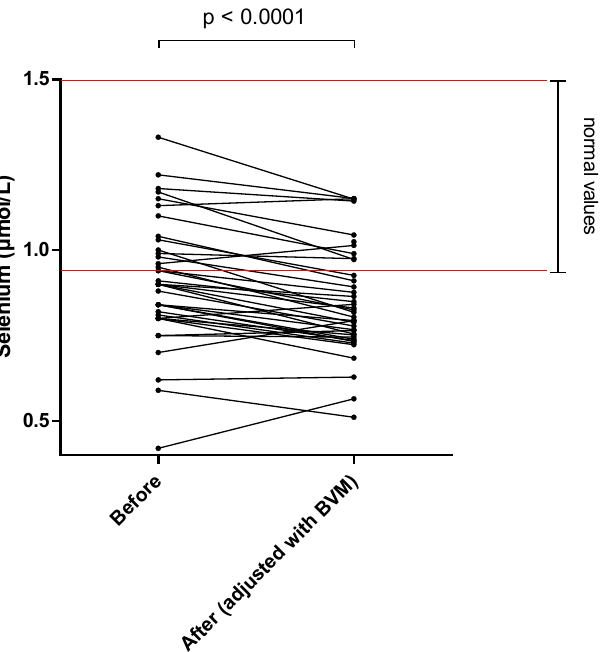
Figure 7. Zinc blood concentration before and after one 4 h-HDF session (paired t -test).